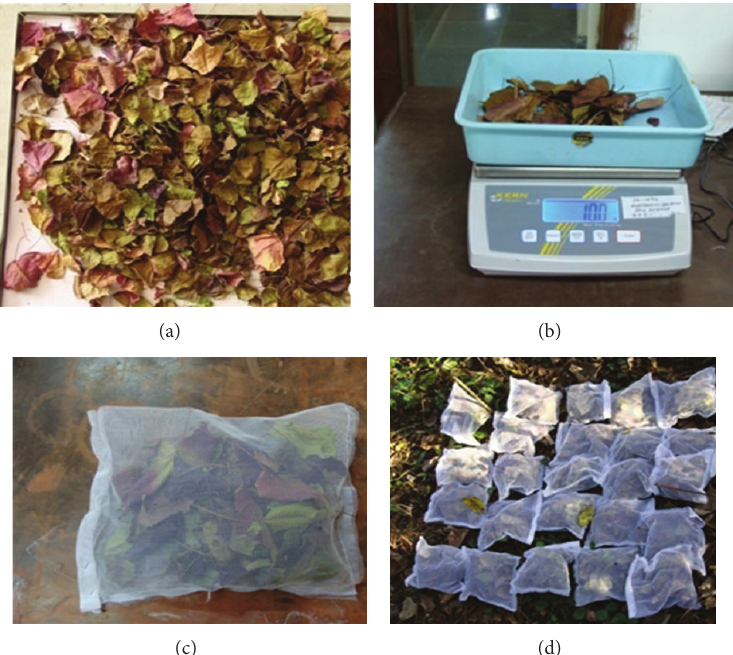
Figure 2: (a) Oven dried senescing leaves, (b) 10g of leaves weighed, (c) litter bags of dimension 25 × 20 cm 2 , and (d) litter bags placed in the permanent plot.